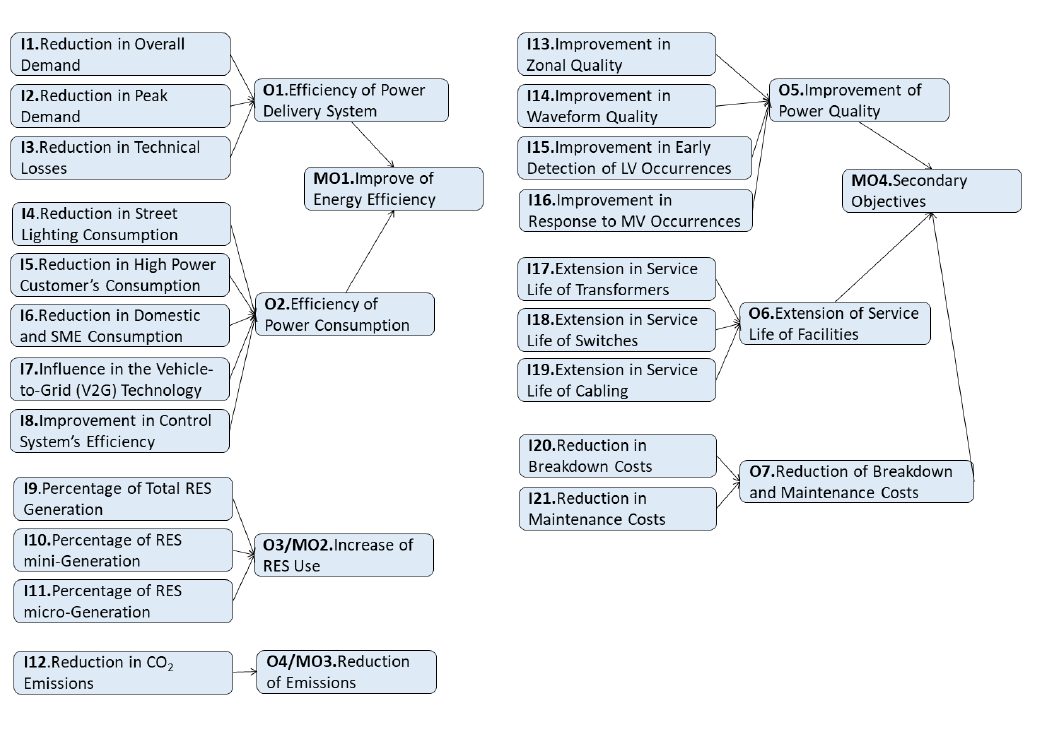
Figure 2. Smart Grid Assessment through Indicators, Objectives, and Macro-objectives